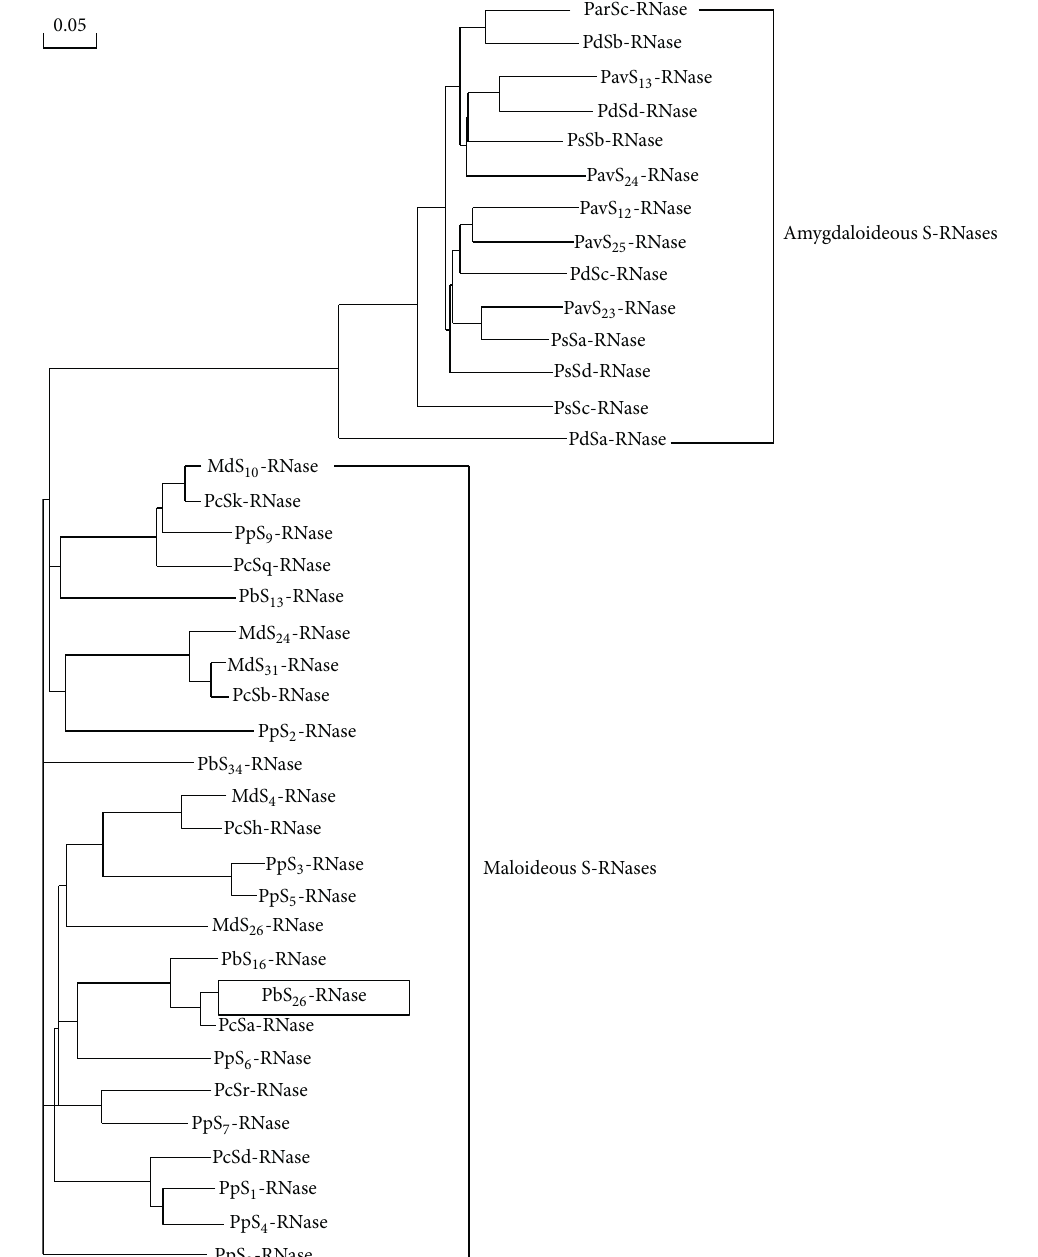
-RNase is boxed. 26